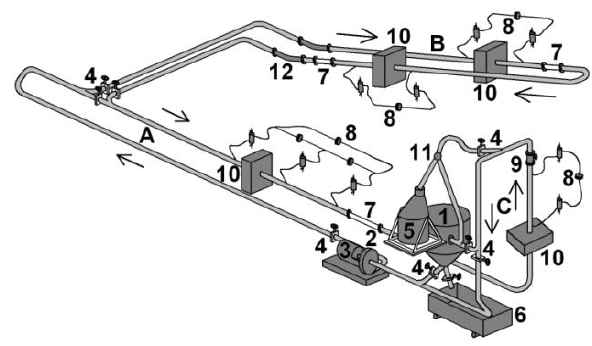
Fig. 1. Experimental test loop D = 100 mm (IH AS CR)